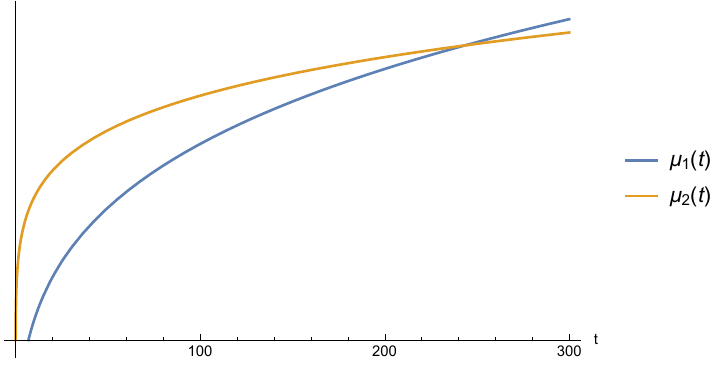
Fig. 6 The solutions of the initial value problem 40–41 for α = 0 . 1